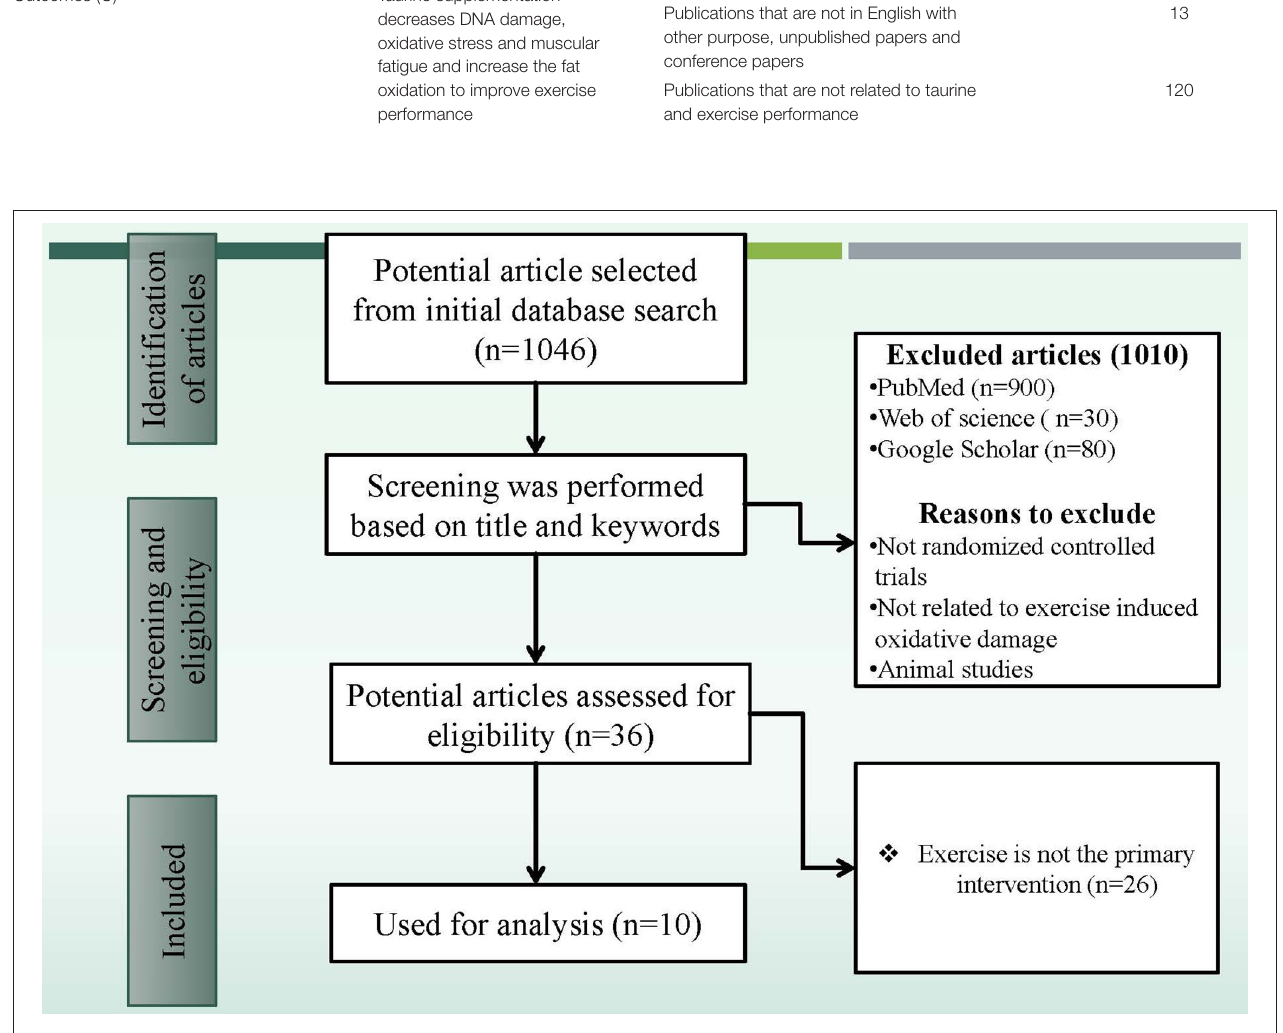
FIGURE 1 | The search flowchart for screening process.